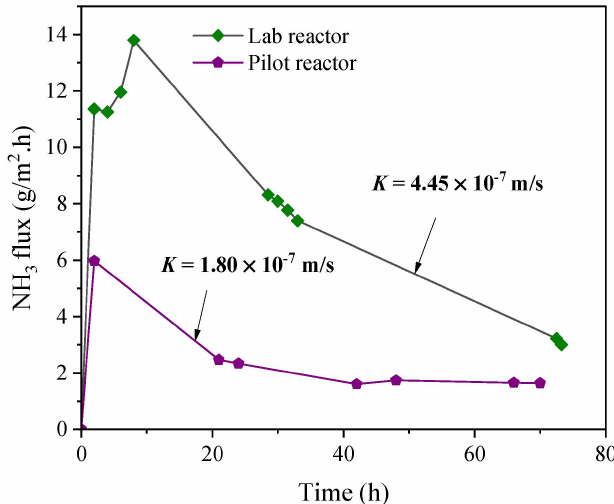
Figure 6. NH 3 flux of lab- and pilot-scale reactors using untreated landfill